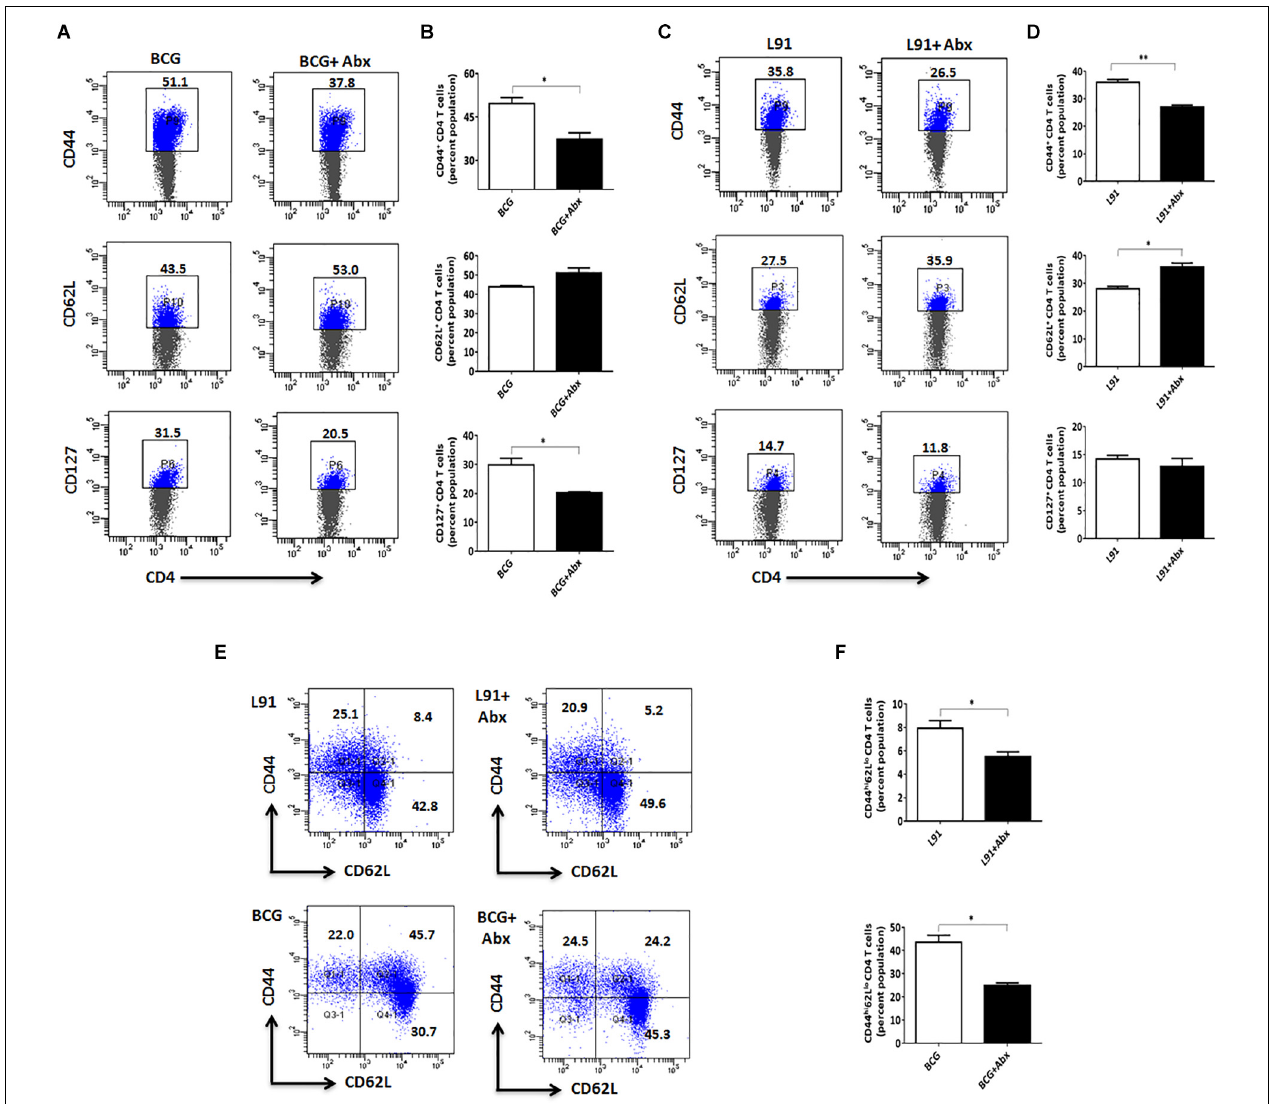
FIGURE 4 | Gut dysbiosis hampers the activation and generation of memory T cells in secondary lymphoid organs. The cells isolated from the spleen and lymph nodes of Abx treated and BCG or L91 vaccinated mice were cultured, as indicated in the legends of Figure 2 . The cells obtained were gated on CD4 + T cells